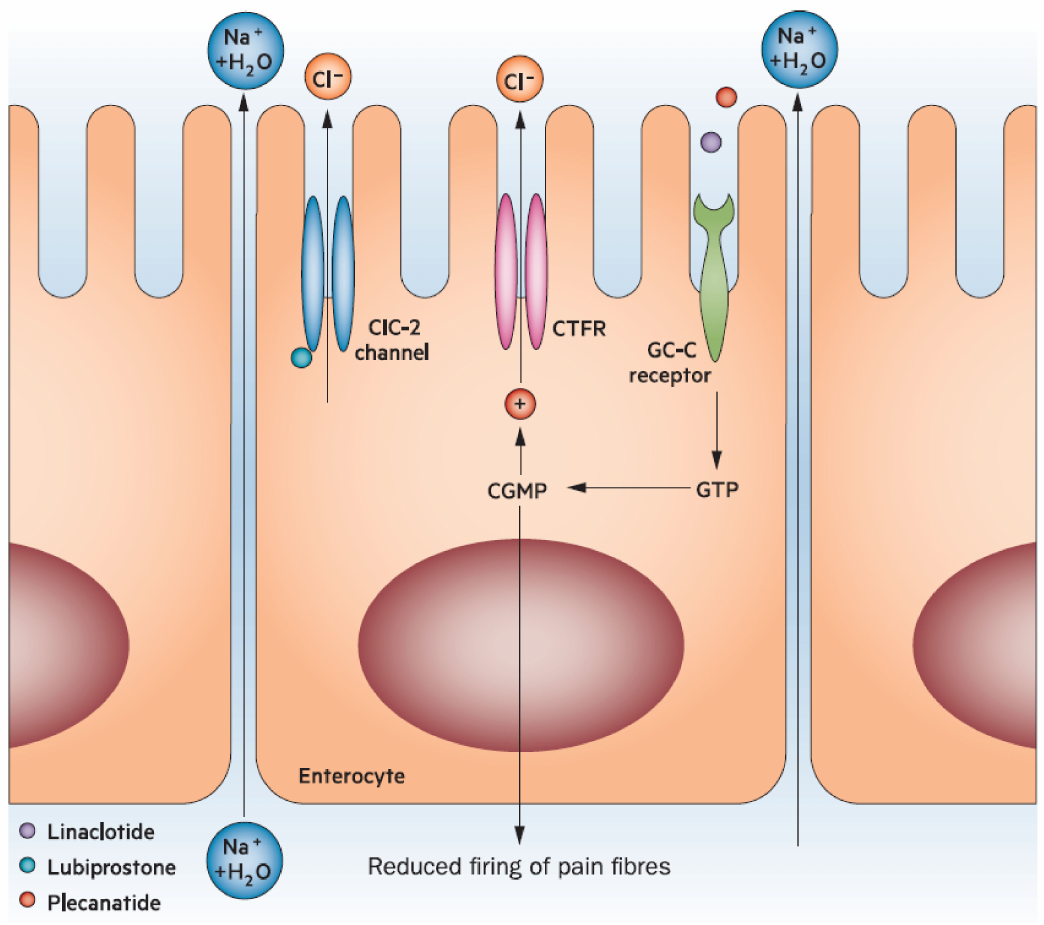
Figure 3. Mechanism of action of common therapies used to manage chronic constipation. Reprinted by permission from Springer Nature Custom Service Center GmbH: Nature Reviews Gastroenterology & Hepatology Agents that act luminally to treat diarrhea and constipation. Menees, S., Saad, R., Chey, W.D., 2012 [42]. Chloride channel activation in the treatment of constipation. ClC-2, type-2 chloride channel; CFTR, cystic fibrosis transmembrane regulator; GC-C, guanylate cyclase-C; GTP, guanosine triphosphate; cGMP, cyclic guanosine